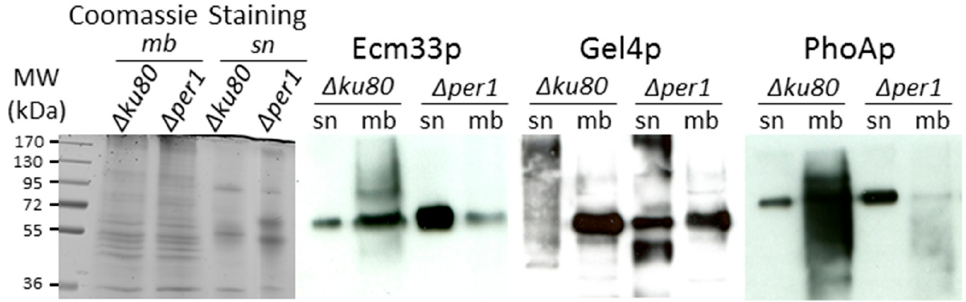
Figure 5. Western blot detection of GPI-APs. Three GPI-APs were analyzed in the total membrane fraction and culture supernatant of parental and and Δ per1 mutants. sn: culture supernatant, mb: membrane extract. (30 μ g of protein were loaded by lane).